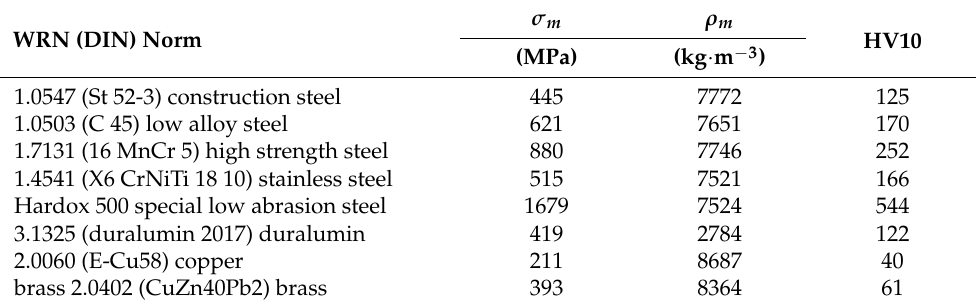
Table 3. Samples from 34CrMo4 steel used for the production of pressure cylinders: austenitized, quenched and tempered. Sample Mark (10 mm Thick)